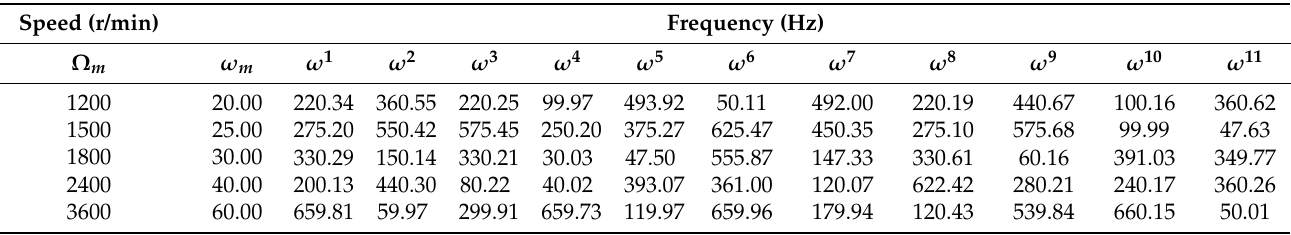
Table 7. No load coupled to the motor shaft: the rotor shaft mechanical frequency and the values of the frequencies corresponding to the 11 peaks of the magnitude of the spectrum of the noise signal. Speed (r/min)